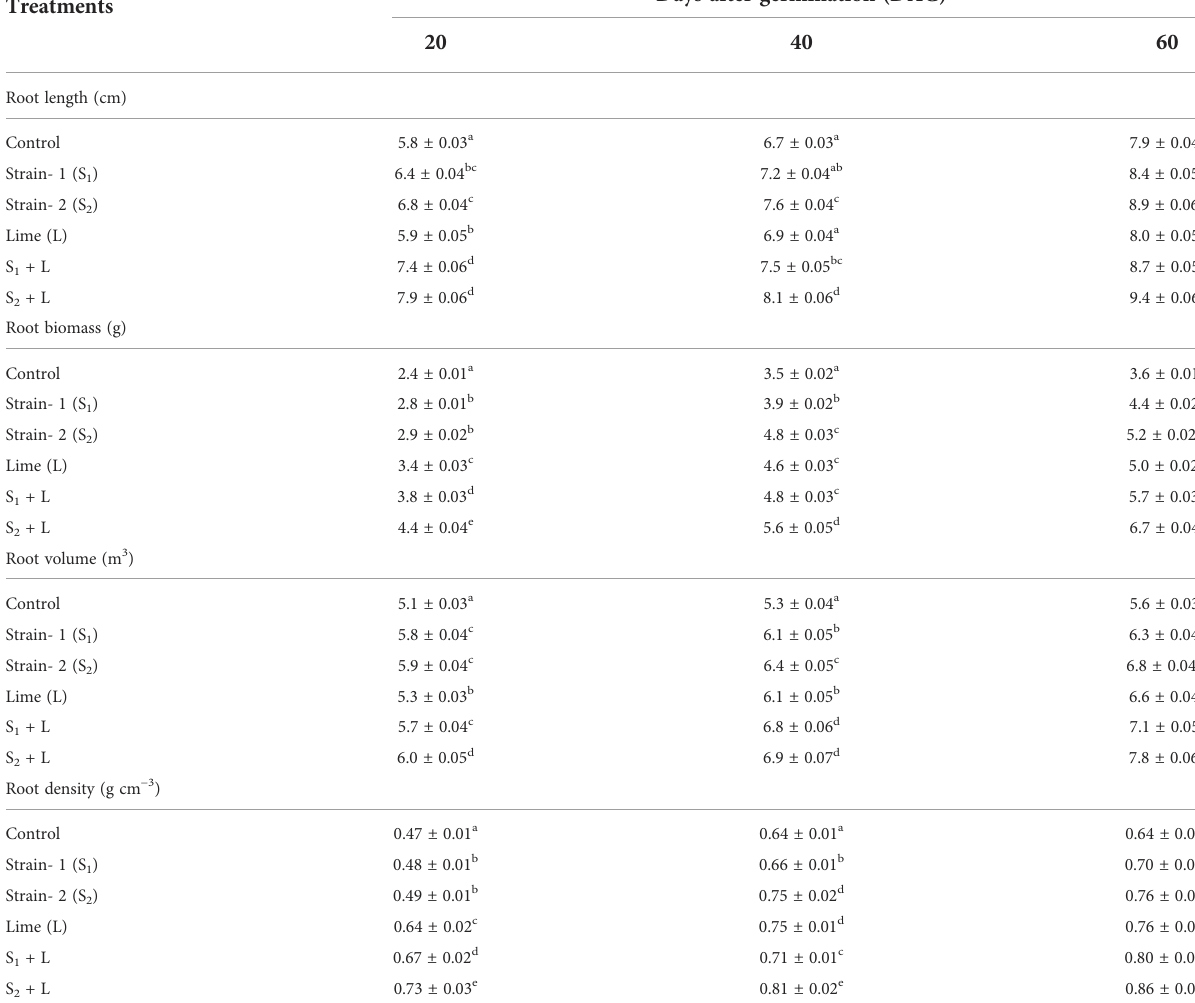
TABLE 3 In fl uence of Rhizobium strains on root characteristics of French bean crop.